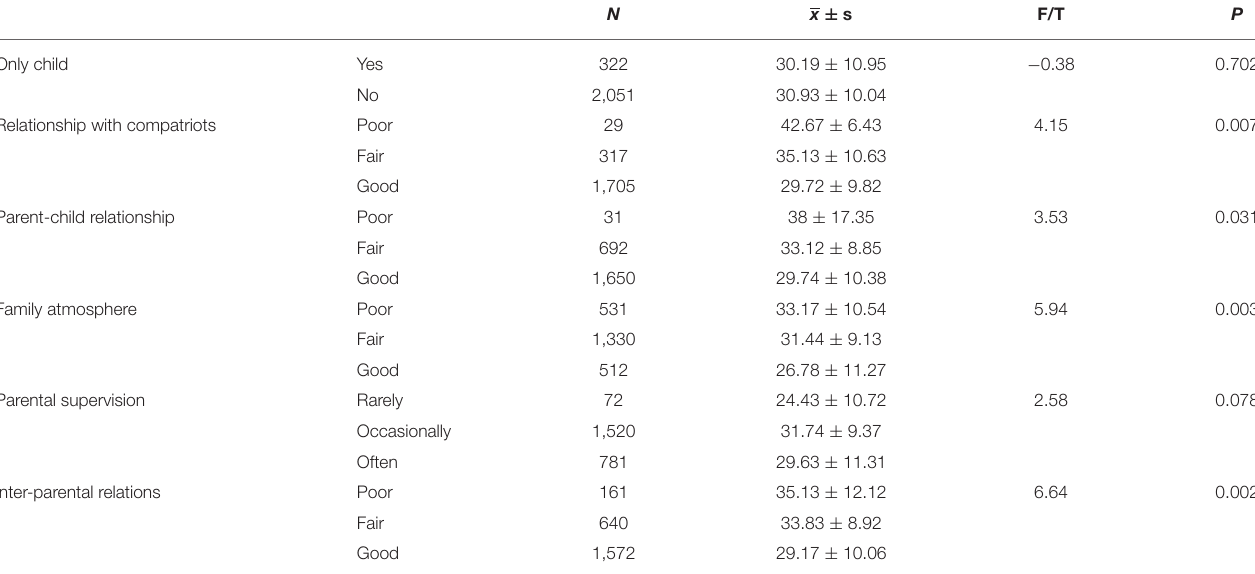
TABLE 1 | Differential analysis of family process factors of online social anxiety ( n =